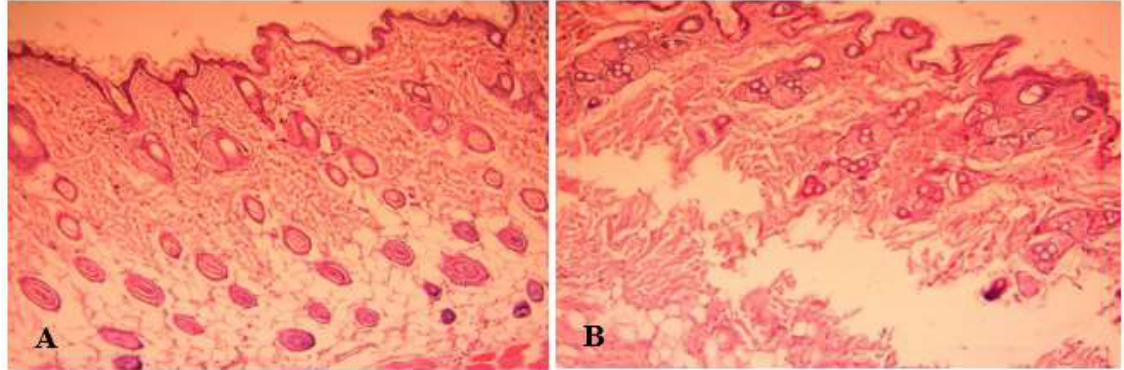
Figure 9. Comparison between phenolic compound of Salvia frigida treated group (A) and Tacrolimus treated group (B) (10x): ordinary Hematoxylin and eosin stain.